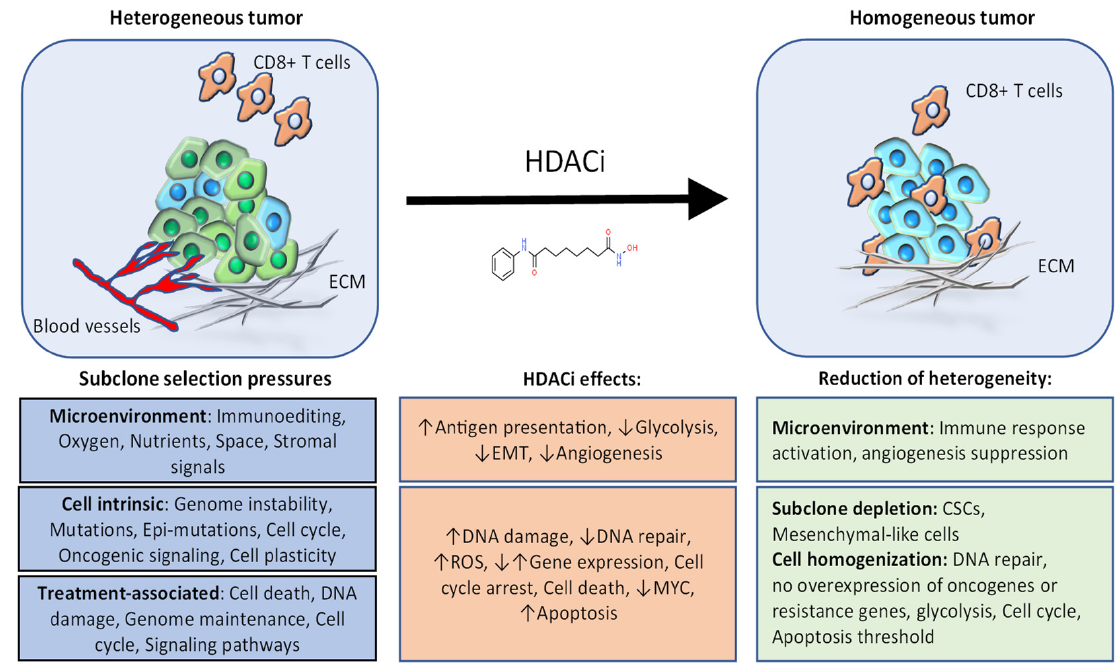
Figure 3. A schematic illustrating how HDAC inhibitors could be utilized to reduce heterogeneity in cancer. During cancer progression, subclone selection pressures from the microenvironment, in-